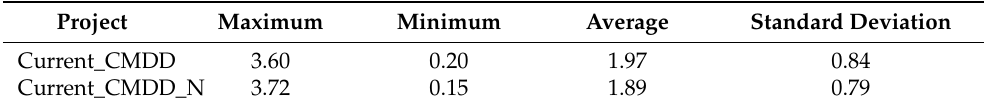
Table 3. Canopy morphological data from field surveys and from BDGM and HDCM simulations in 2016.